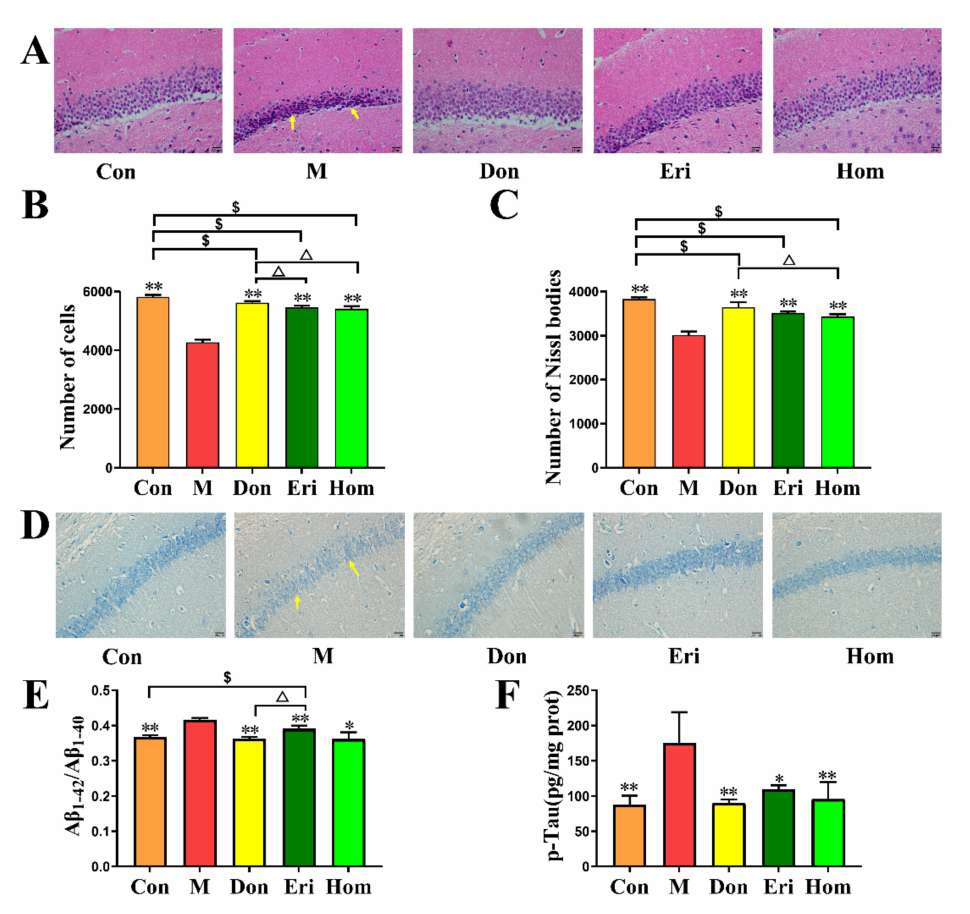
Figure 3. Effects of Eri and Hom on the hippocampus tissue of mice induced by A β 25–35 . ( A ) Pathological section of the hippocampus of mice in various groups (20 µ m). ( B ) The number of hippocampal cells in each group of mice. ( C ) The number of the hippocampus in each group, n = 5. ( D ) Nissl staining in the hippocampus of mice in various groups (20 µ m). ( E , F ) The levels of A β 1–42 /A β 1–40 and p-Tau in mice hippocampus, n = 4. The data were expressed as the mean ± SD., * p <0.05, ** p < 0.01 compared with the M group, (cid:52) p < 0.05 compared with the Don group, $ p < 0.05 compared with the Con group. The yellow arrows in the figure indicate damaged neuronal cells. Con means the control, M means the model, Don means the donepezil, Eri means the eriodictyol, Hom means the